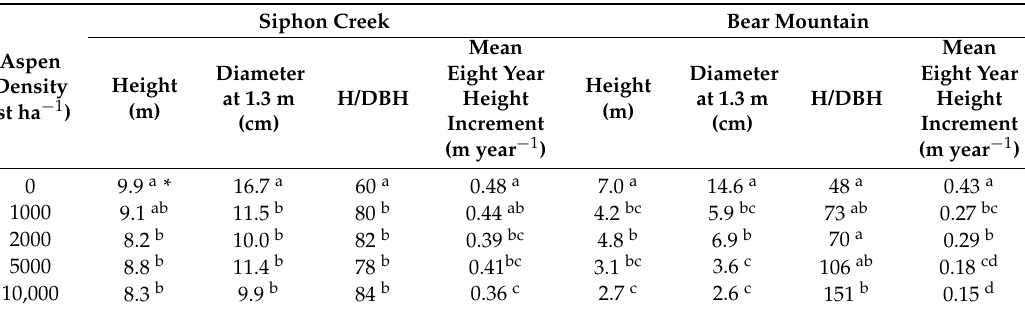
Table 2. Mean white spruce height, diameter, height/diameter ratio and eight year height increment (2002 measurement to 2010 measurement) at Siphon Creek (25 years old) and Bear Mountain (21 years old) for the four largest diameter spruce in each